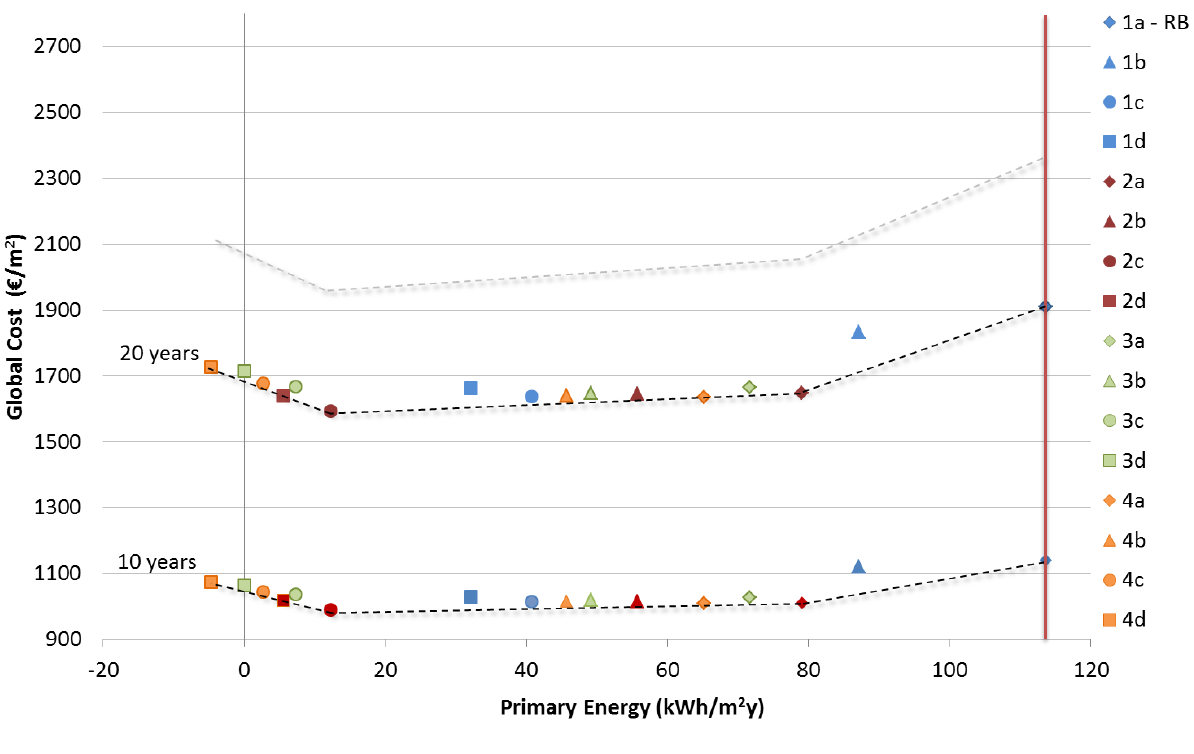
Figure 13. Sensitivity analysis with regard tothe reduction of the calculation period to 20 and 10